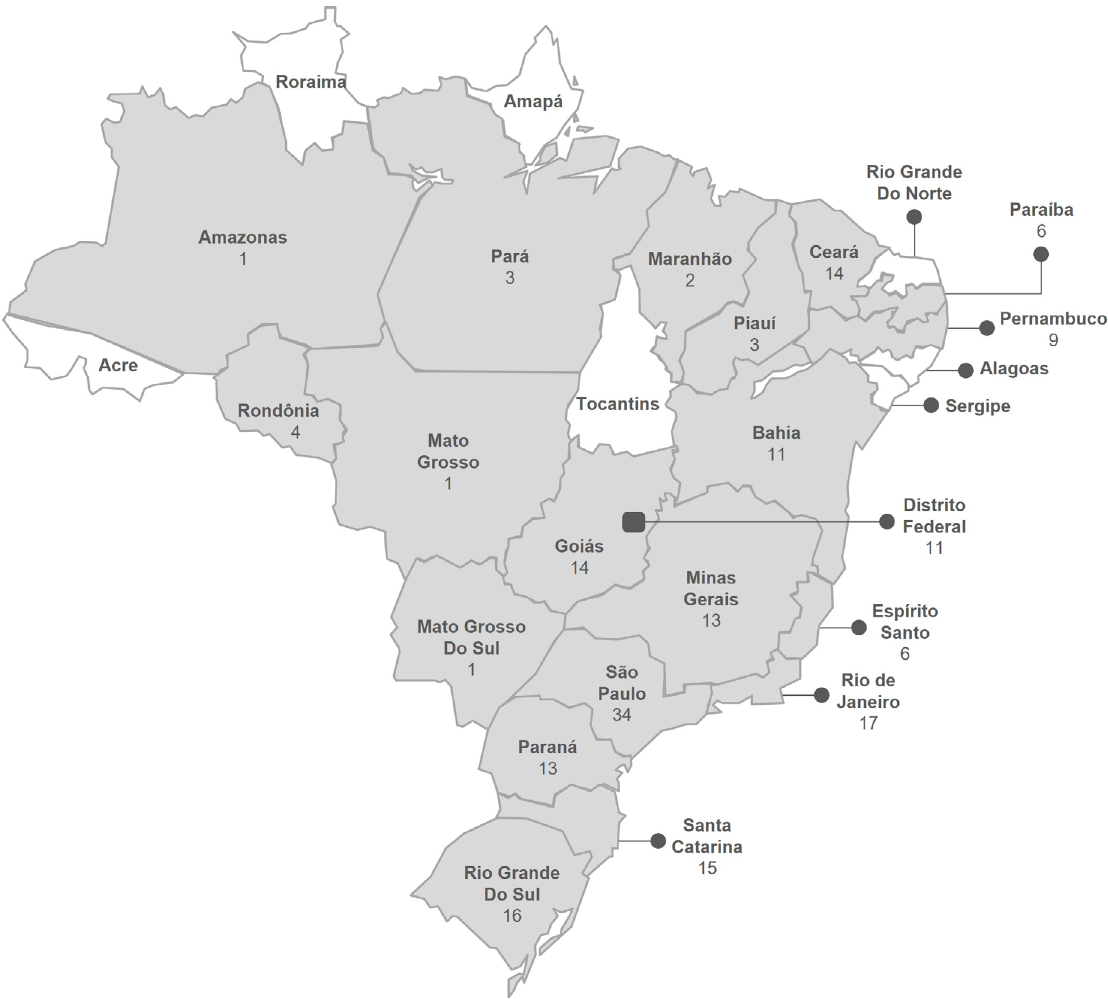
Figure 1. Geographical distribution of study participants. Data refer to participants of the lay users group (patients with phenylketonuria, their families, and caregivers, all living in